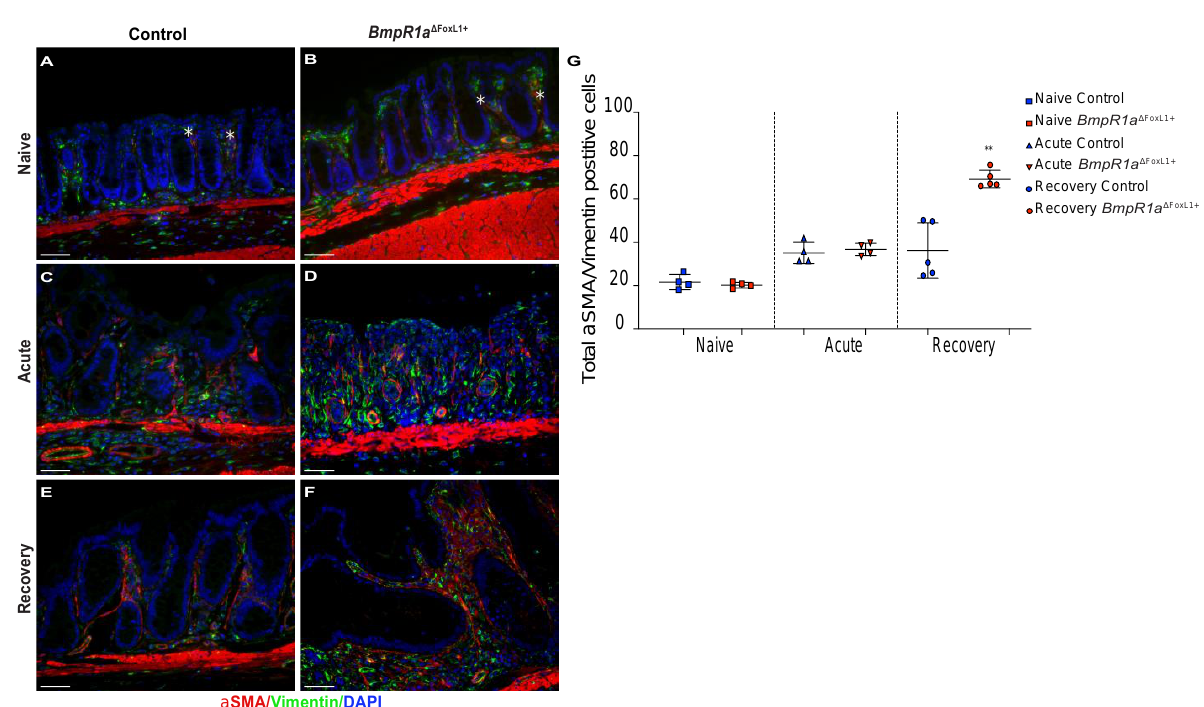
Figure 6. Myofibroblasts are localised near stem cells and along the epithelial sheet upon recovery in BmpR1a Δ FoxL1+ mice. ( A ) Under naive condition, control mice demonstrated the basal myofibroblast (white asterisks) population ( B ) which was comparable in BmpR1a Δ FoxL1+ mice. ( C ) During the acute phase, control mice exhibited an increase in myofibroblasts (white asterisks) in regard to the naive condition with ( D ) with a similar increase in BmpR1a Δ FoxL1+ mice. ( E ) After recovery, control mice showed a return to the basal level in myofibroblast population seen under naive condition ( F ) while BmpR1a Δ FoxL1+ mice still presented a strong presence of myofibroblasts scattered in their mucosa with these cells also found in the region associated with the stem cell niche and progenitor cells. ( G ) Myofibroblasts count along the crypt axis revealed a 1.9-fold increase in myofibroblasts in mutant mice compared to controls after the recovery phase. The myofibroblast population was found to be similar in both groups in the naive condition and during the acute phase. Scale bar: 50 μm. Mann– Whitney test ( N = 4 – 6) ** p < 0.01.